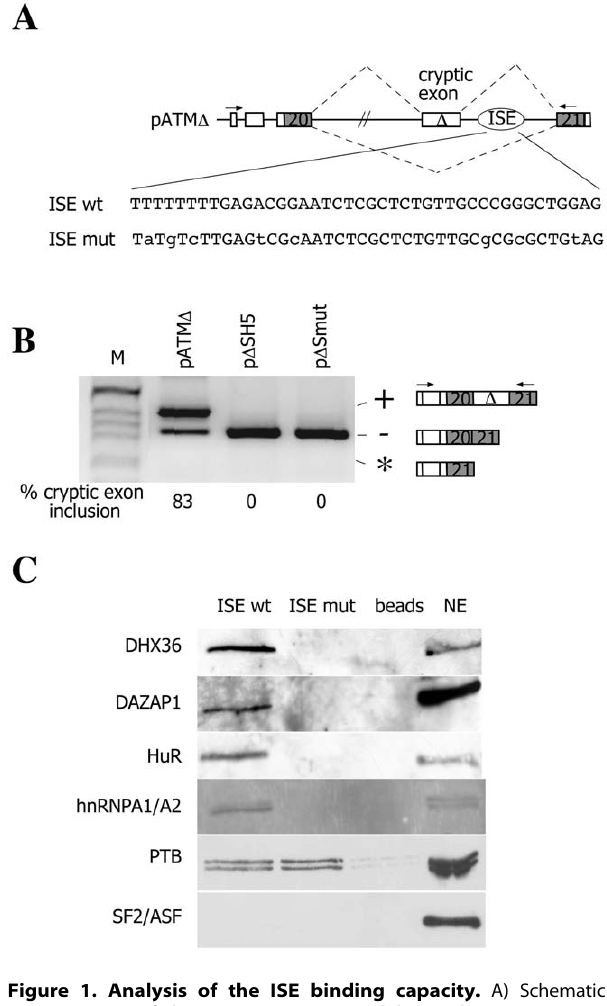
Figure 1. Analysis of the ISE binding capacity. A) Schematic representation of the pATM minigene. a -globin and ATM exons are white and grey boxes, respectively, and introns are lines. The cryptic 65 bp ATM exon activated by the GTAA deletion ( D ) is indicated and the oval show the position of the ISE. Splicing pattern is represented with diagonal dashed lines and the arrows indicate location of the primers used in RT-PCR analysis. The nucleotide sequence of normal and mutant ISE is shown. B) Splicing assay. The p D minigenes were transfected in HeLa cells and the pattern of splicing analyzed with E16 and 2550 primers. In p D SH5 the ISE has been deleted. RT-PCR fragments were resolved on 2% agarose gel. M is the molecular weight marker. The cryptic exon inclusion and exclusion are indicated. The asterisk corresponds to a minor spliced product without the hybrid exon made of globin exon 3 and ATM exon 20. The % of cryptic exon inclusion is indicated and is the mean of three independent experiments. C) Western blot analysis of pull down assay performed on ISE wt and ISE mut sequences. The binding analysis of RNA helicase DHX36, DAZAP1, HuR, hnRNPA1, PTB and SF2/ASF protein. Upon in vitro transcription, RNAs were covalently bound to the agarose beads and incubated with HeLa nuclear extract. After washing steps, the pulled down proteins were loaded on SDS-PAGE gel and analyzed by western blotting using antibodies against RNA helicase DHX36, DAZAP1, HuR, hnRNPA1, PTB and SF2/ASF proteins. The nuclear extract (NE) corresponds to the 1/20 of the amount used in pull down assay. ISE wt sequence pulled down RNA helicase DHX36, DAZAP1, HuR, hnRNPA and PTB whereas the ISE mut fraction was enriched only in PTB. SF2/ASF was not detected in either of fractions.